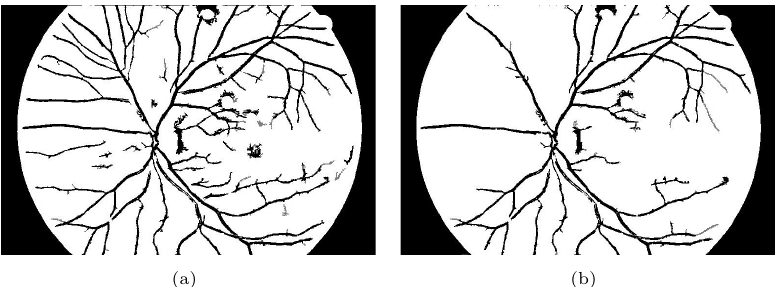
Figure 6. Extracted vasculature: (a) using w × w pixels, (b) using pixels by scheme in Figure